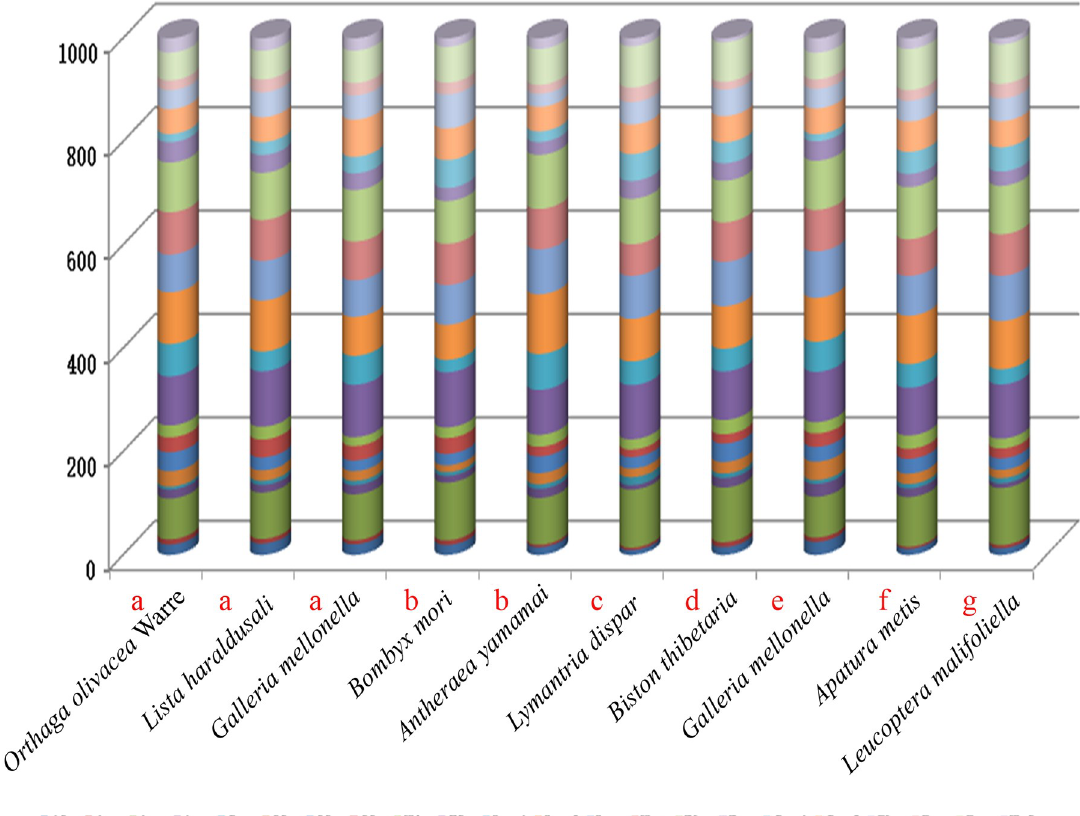
Fig 2. Codon usage patterns of O . olivacea Warre mitochondrial genome compared with other species of the Lepidoptera. The lowercase letters above species name (a, b, c, d, e, f and g) indicate the superfamily which the species belong to (a: Pyraloidea , b: Bombycoidea , c: Noctuoidea , d: Geometroidea , e: Tortricoidea , f: Papilionoidea , g: Yponomeutoidea